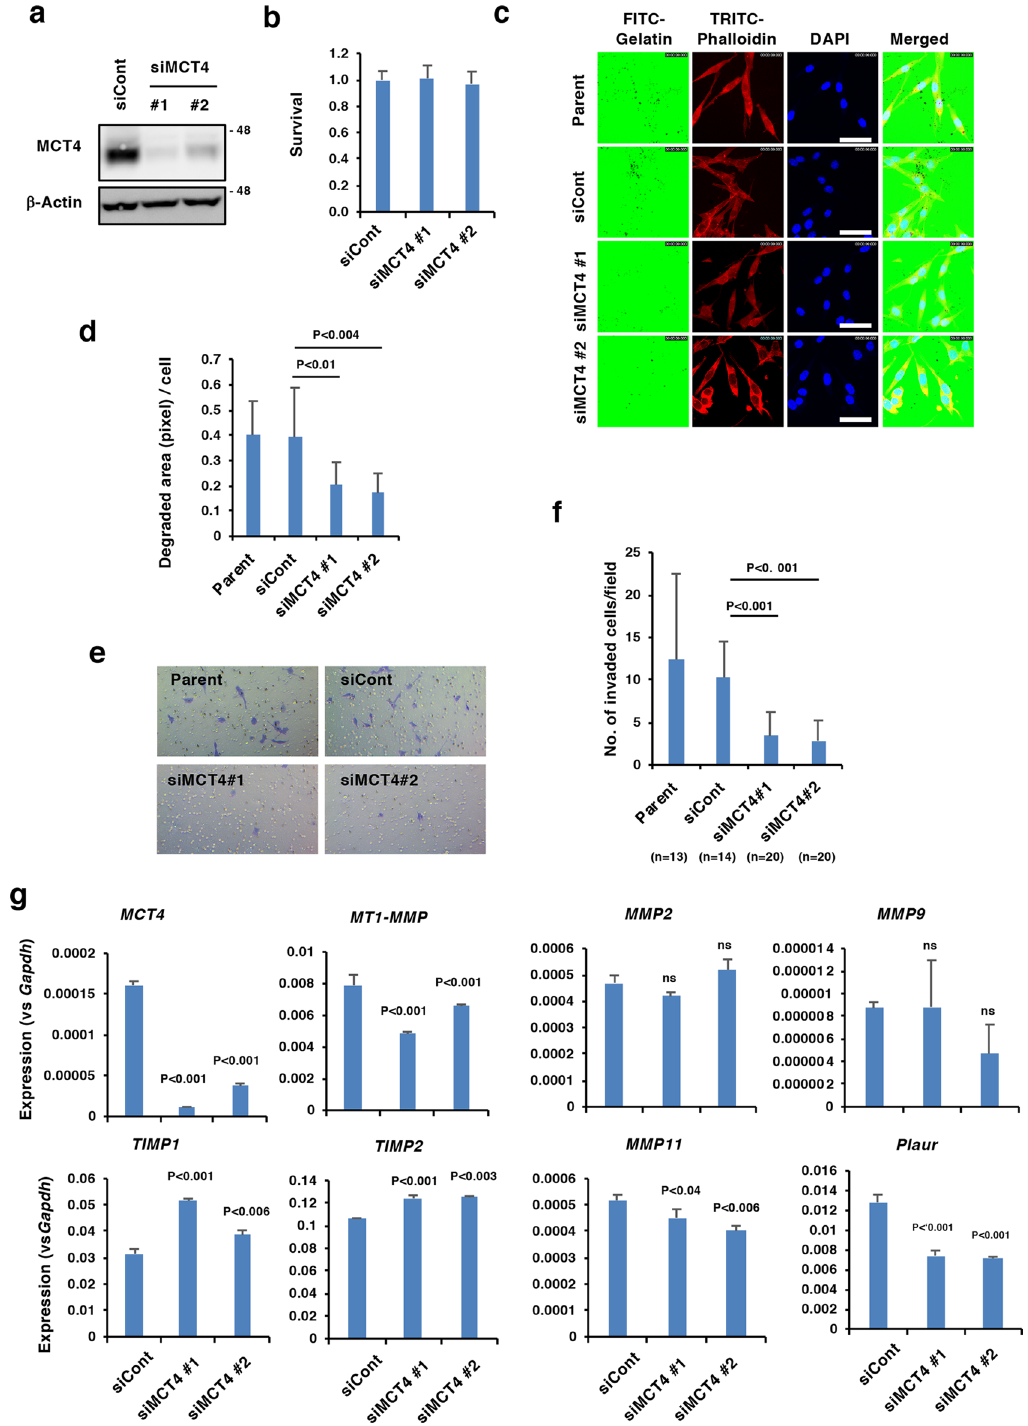
Figure 2. Effect of MCT4 knockdown on the invasiveness of P29mtB82M cells. ( a ) Western blot analysis of the expression of MCT4 in P29mtB82M cells transfected with a control siRNA (siCont) or an MCT4 siRNA (siMCT4 #1 and #2). β-Actin was used as a loading control. Uncropped Western blot images are shown in Supplementary Fig. S12. ( b ) Proliferation of P29mtB82M cells transfected with a control siRNA (siCont) or an MCT4 siRNA (siMCT4 #1 and #2), as measured by WST assay. The cells were cultured for 2 days. Error bar: SD. ( c ) Gelatine invadopodia assay. Images showing the degradation of FITC-labelled gelatine at the invadopodia of P29mtB82M cells transfected with a control siRNA (siCont) or an MCT4 siRNA (siMCT4 #1 and #2). Bar. 20 μm. ( d ) Quantitation of the degraded area/ cell in the invadopodia assay. Error bar: SD. ( e ) Matrigel invasion assay. Images showing invasion of P29mtB82M cells transfected with a control siRNA (siCont) or an MCT4 siRNA (siMCT4 #1 and #2). ( f ) Quantitation of the number of invaded cells. Error bar: SD. ( g ) RT-qPCR analysis of the expression of MCT4 and matrix degradation-related genes in P29mtB82M cells transfected with a control siRNA (siCont) or MCT4 siRNAs (siMCT4 #1 and #2). Error bar: